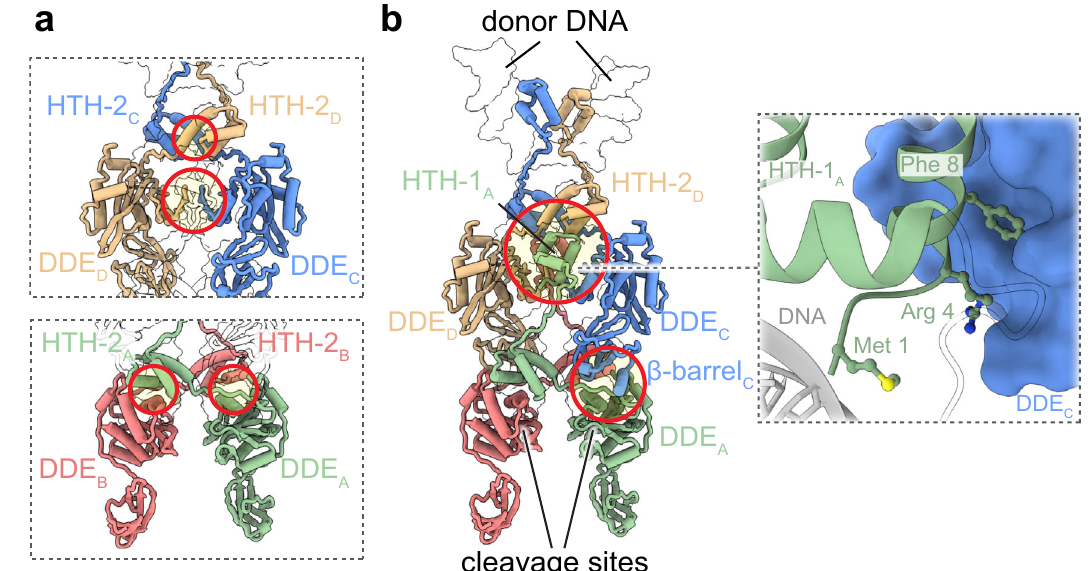
Fig.4|Protein – proteininteractionsintheIstAtetramer.a Themaininteraction areasbetweentheupper(HTH-2/HTH-2andDDE/DDEofchainsCandD,toppanel) and lower (HTH/DDE of chains A and B, bottom panel) transposase monomers are highlighted with red circles. b Interactions between the upper and lower IstA monomersoccurbetweenHTH-1ofonelowerchainandHTH-2/DDEofbothupper